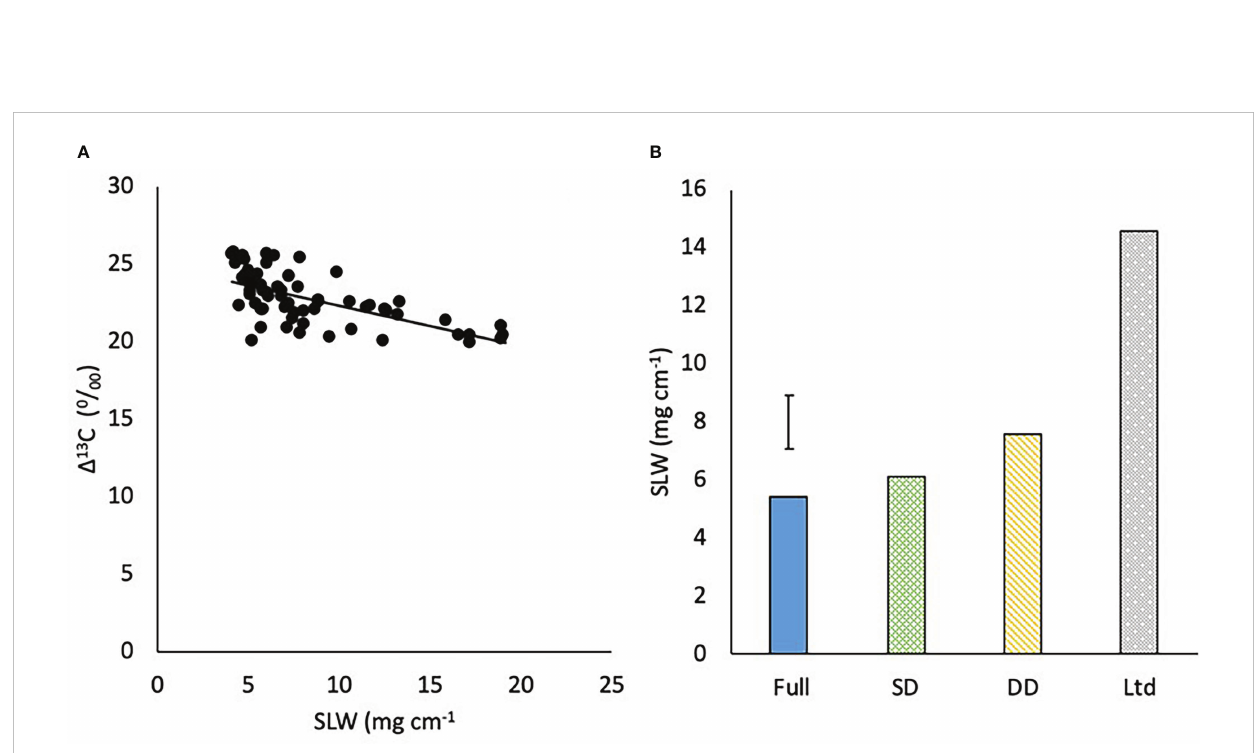
FIGURE 11 (A) The relationship between carbon isotope discrimination ( D 13 C) and speci fi c leaf weight (SLW) (P<0.001 R 2 = 0.41) and (B) the speci fi c leaf weight (SLW) of sugar beet grown under four different irrigation regimes, fully irrigated (Full), single drought (SD), double drought (DD) and continually water limited (Ltd). Error bar shows irrigation LSD (P=0.016 DF=31 LSD=1.83).